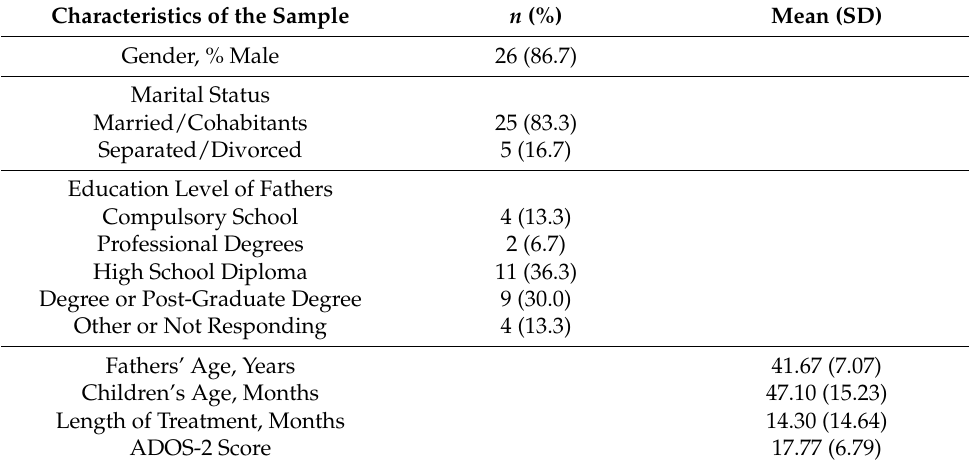
Table 1. Characteristics of the